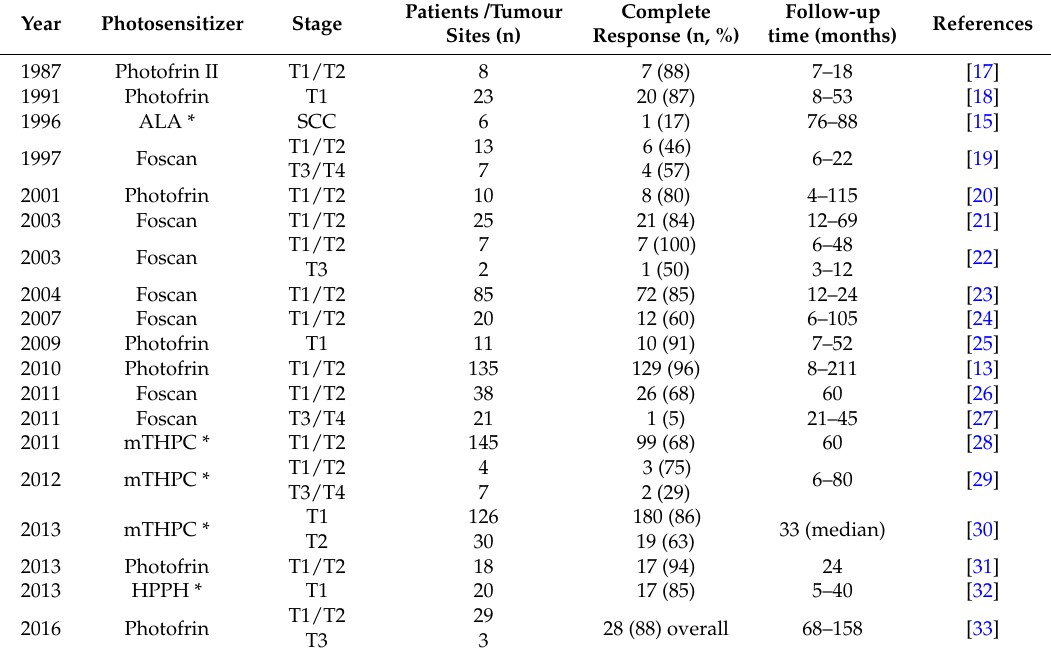
Table 1. Summary of the use of photodynamic therapy in oral cancer with intent-to-cure treatment and over 3-month follow-up (in chronological